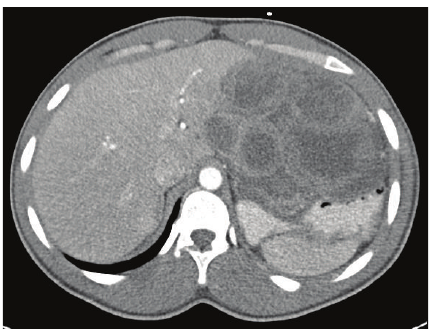
Figure 2: CT image showing increase in tumor size four months after doubling the dosage of imatinib to 800mg per day.